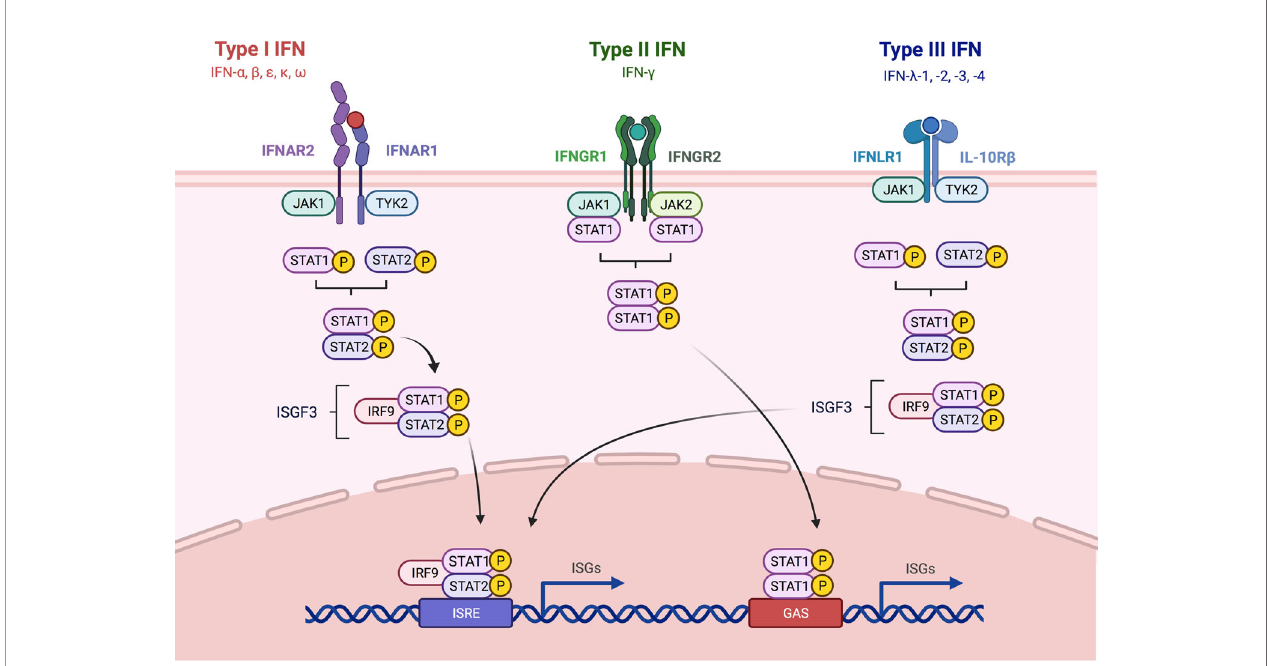
FIGURE 2 | Overview about Type I, -II and -III IFN signaling pathways. The three different types of IFNs discussed in this review signal through distinct receptor complexes on the cell surface. Type I IFNs act through the type I IFN receptor which is composed of the two subunits IFNAR1 and IFNAR2; Type II IFNs act through heterodimers consisting of IFNGR1 and 2 IFNGR2 and type III IFNs signal via heterodimers consisting of IL-10R2 and IFNLR1. Binding of type I and type III IFN to their respective receptor complexes triggers phosphorylation of associated JAK1 and -2, leading to the recruitment and subsequent phosphorylation of STAT1 and -2. STAT 1 and -2 form together a complex, which in turn recruits IRF9 which results in the formation of ISGF3. Engagement of type II IFN to the IFNGR1/2 complex leads to phosphorylation JAK1 and -2, and subsequently STAT1 is recruited and phosphorylated. Both IRF9 and the homodimer consisting of phosphorylated STAT1 can then translocate into the nucleus and bind to ISRE and GAS elements in the promoter region of ISGs, leading to the induction of the expression of antiviral genes. IFN, interferon; STAT, signal transducer and activator of transcription; JAK, Janus kinase; TYK, tyrosine kinase; IL, interleukin; IFNAR, interferon alpha receptor; IFNGR, interferon gamma receptor; IFNLR, interferon lambda receptor; ISGF3, interferon-stimulated gene factor 3; IRF9, interferon regulatory factor 9; ISRE, interferon-stimulated response element; GAS, interferon gamma activated site; ISG, interferon-stimulated gene. Adapted from “ Interferon pathay ” , by Biorender.com (2021). Retrieved from